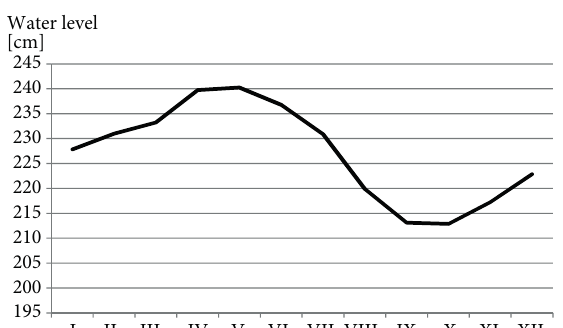
Fig. 3. Lake Serwy monthly mean water level, 1980–2012